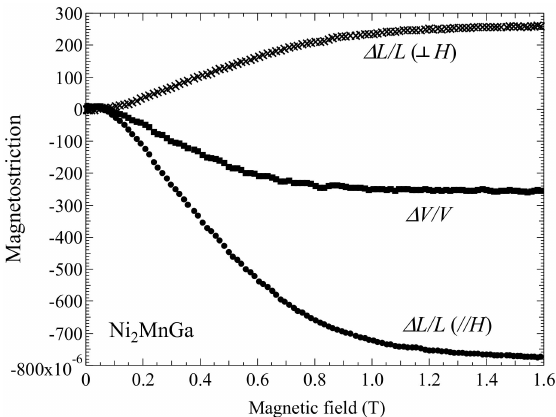
Figure 9. Magnetic field dependence of the magnetostriction at T = 185 K in the martensitic